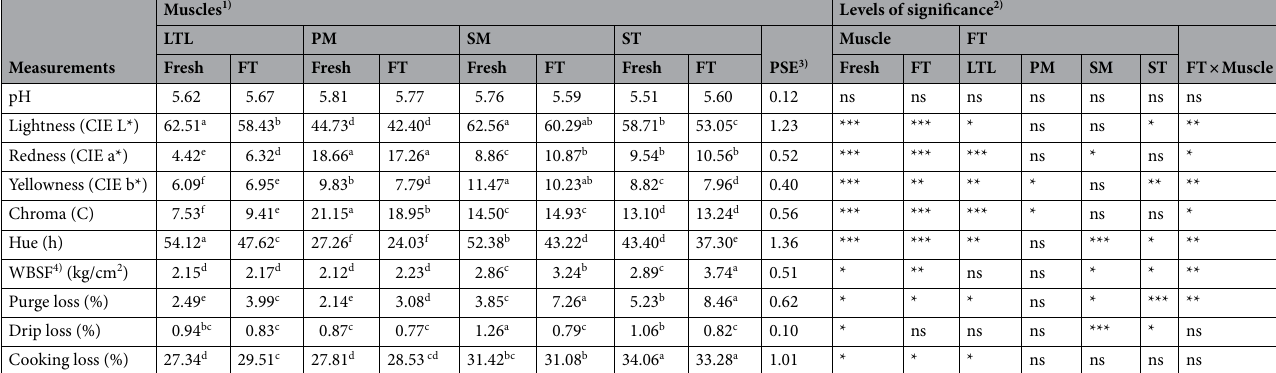
Table 2. Comparison of pH, meat color, water-holding capacity, and shear force between fresh and frozen/ thawed pork in different muscles. 1) LTL, M. longissimus thoracis et lumborum ; PM, M. psoas major ; SM, M. semimembranosus ; ST, M. semitendinosus. 2) ns, not significant; * P < 0.05; ** P < 0.01; *** P < 0.0001; FT, freezing/ thawing; FT × Muscle, combination effect of freezing/thawing and muscle type. 3) Pooled SE. 4) Warner–Bratzler shear force. a–f Means with same superscripts are not significantly different ( P <